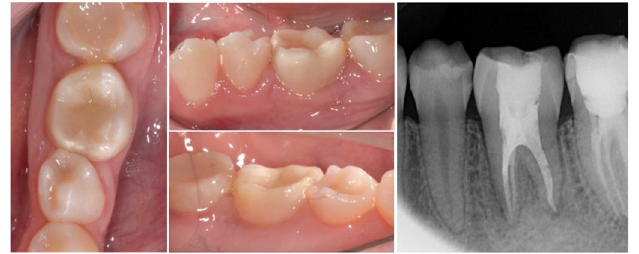
Fig. 6. Clinical and radiological situations 6 months after